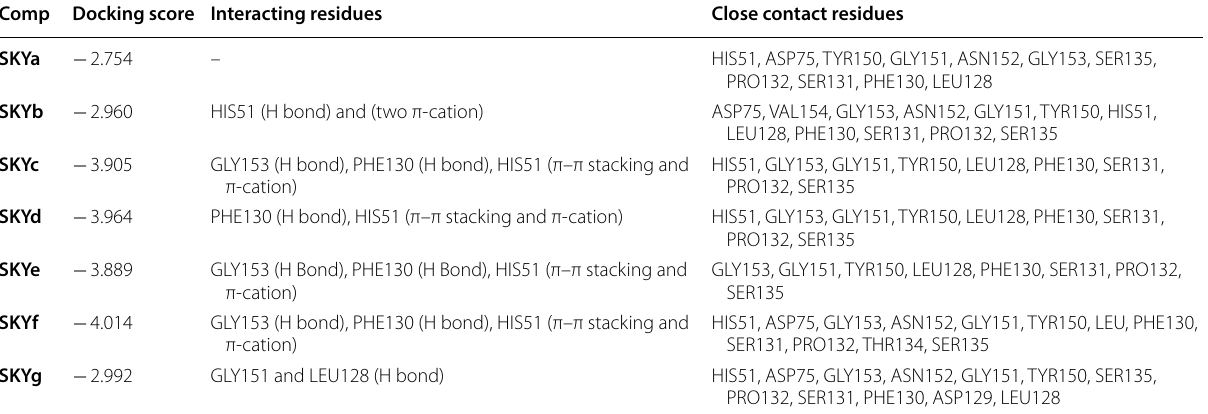
Table 2 Compounds (SKYa–SKYg), docking score, interacting residues and close contact residues Comp Docking score Interacting